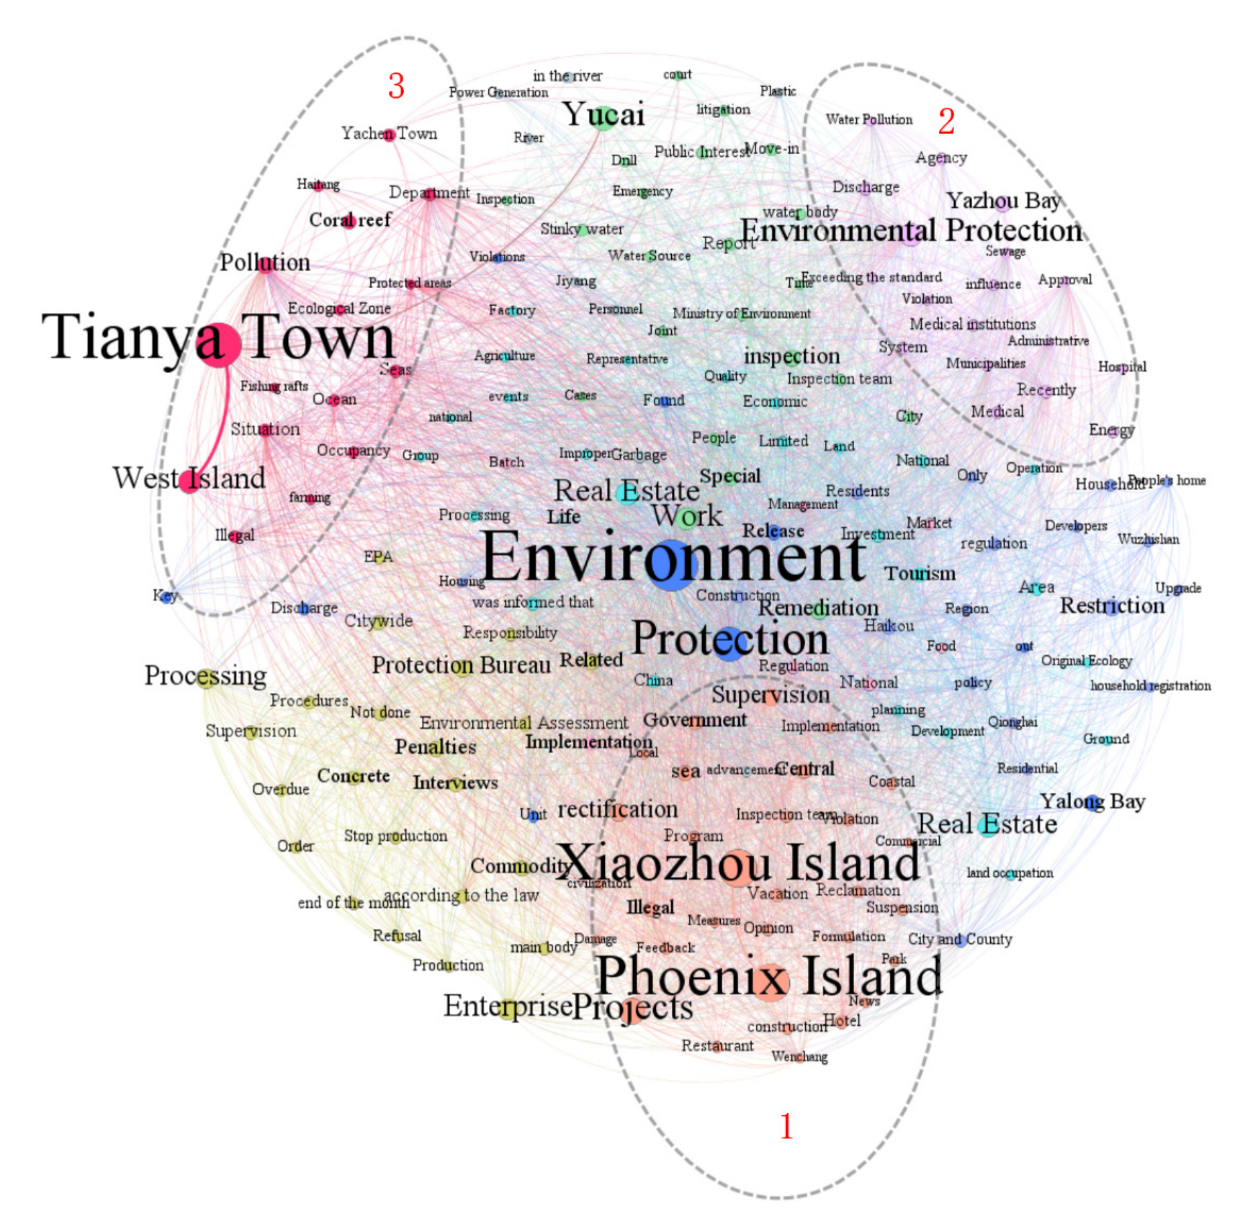
Figure 6. The social semantic network related to negative sentiments.